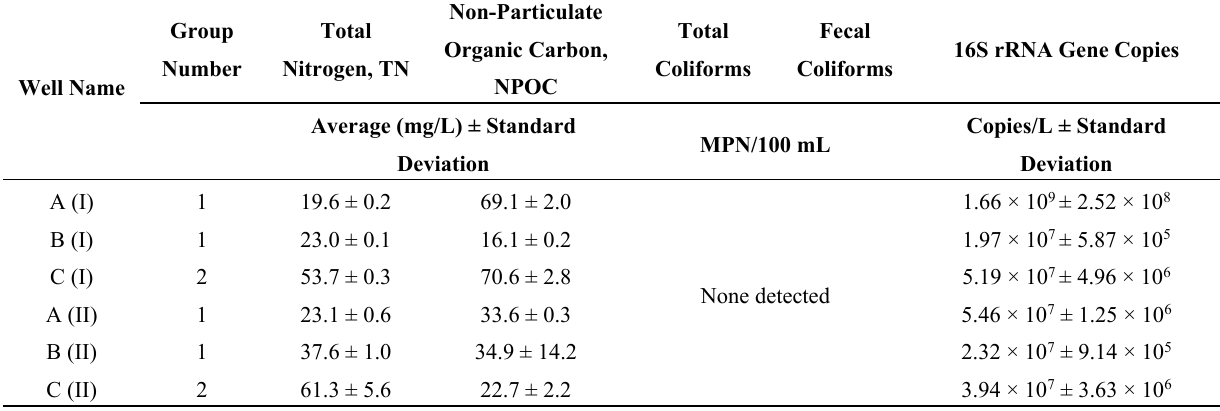
Table 1. Chemical and microbial quality of groundwater samples. A (I), B (I) and C (I) denote groundwater sampled from well A, B and C on the first sampling trip. A (II), B (II) and C (II) denote groundwater sampled from well A, B and C on the second sampling